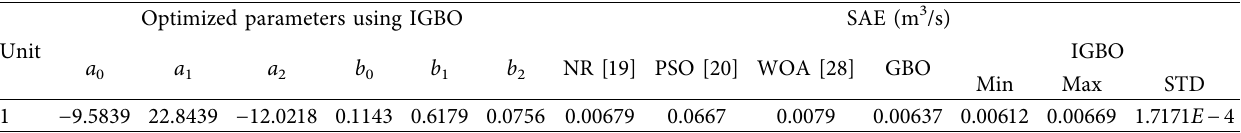
Table 13: Optimized parameters and SAE of model 8.